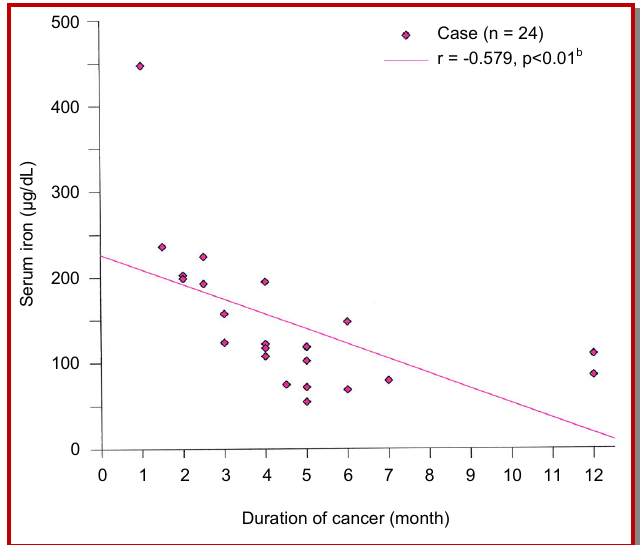
Figure 2: Relationship between serum iron concentration and duration of